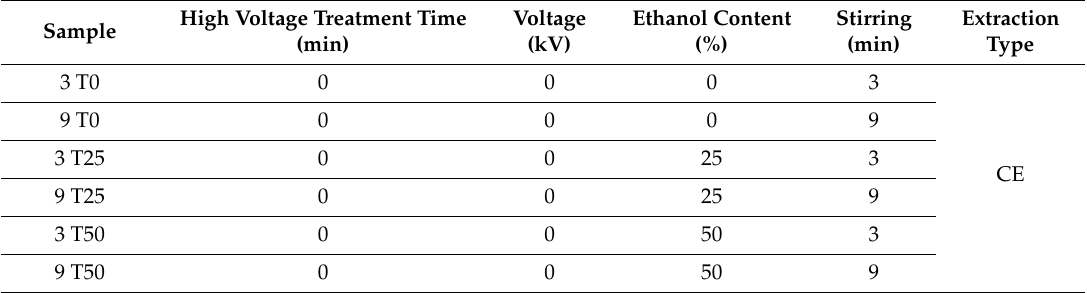
Table 9. Denotation of samples, experimental design and process